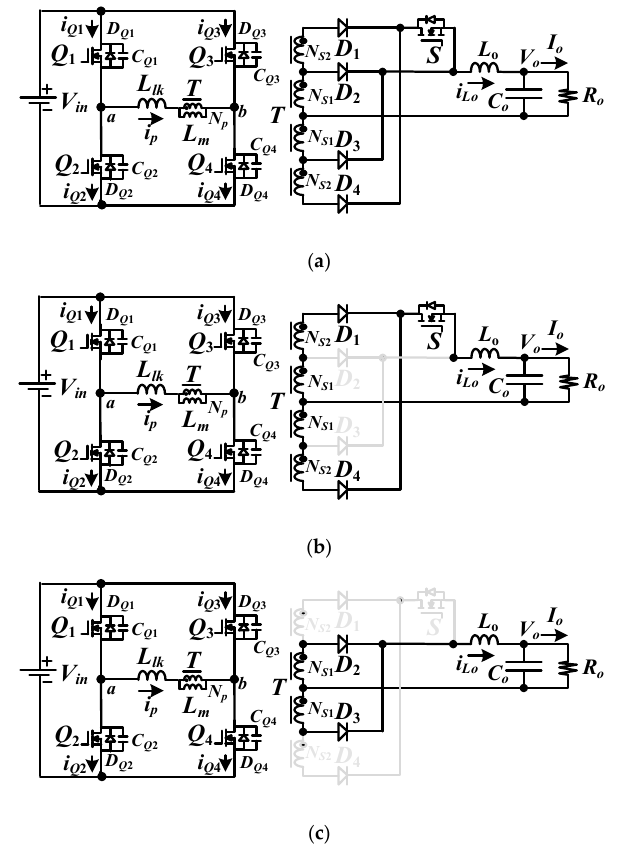
Figure 1. Proposed 6:1 wide voltage range converter ( a ) circuit diagram ( b ) low voltage range operation ( c ) high voltage range operation.